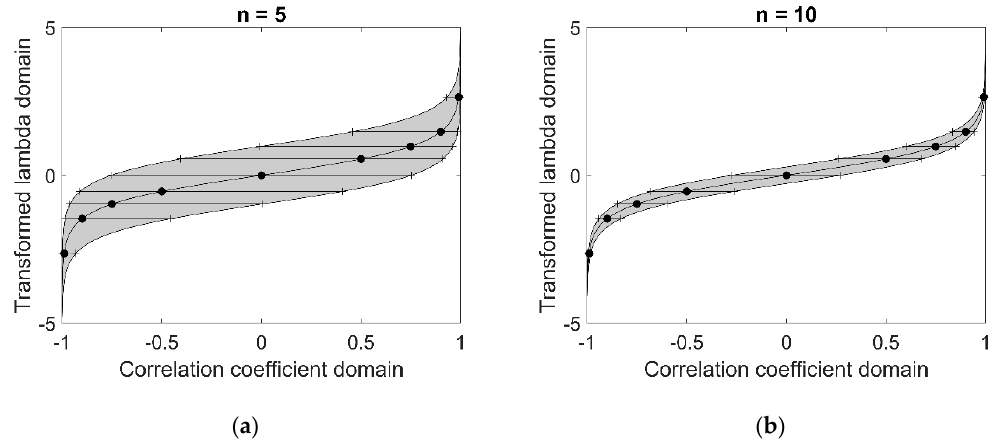
Figure 1. Comparison of the estimated confidence intervals for different correlation coefficients (CCs, horizontal lines) around the estimated CCs (plain dots) and for different values of the sample size: ( a ) n = 5; ( b ) n = 10.